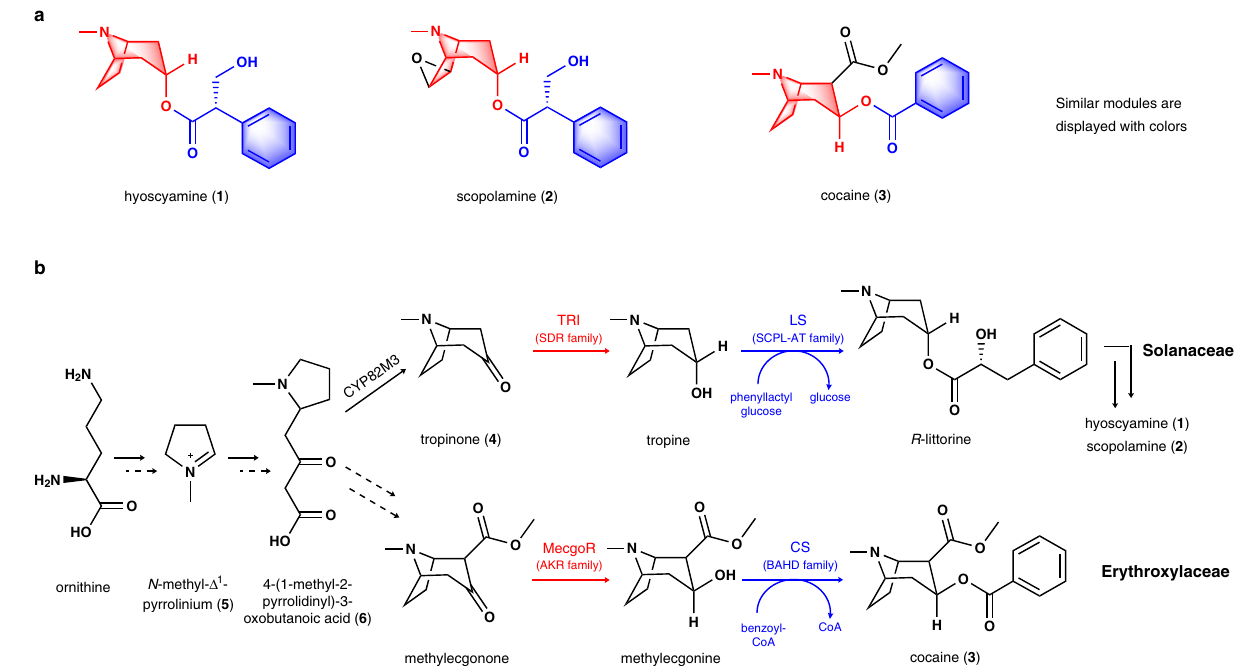
Fig. 1 | Chemical structures and partial biosynthesis steps of TAs. a Structural similarity among hyoscyamine, scopolamine and cocaine. b The enzymes of dif- ferent families usedfor ketone reduction and subsequent esteri fi cation of tropane skeletonsinSolanaceaeandErythroxylaceae.TRItropinonereductaseI,LSlittorine synthase, MecgoR methylecgonone reductase, CS cocaine synthase, SDR short-